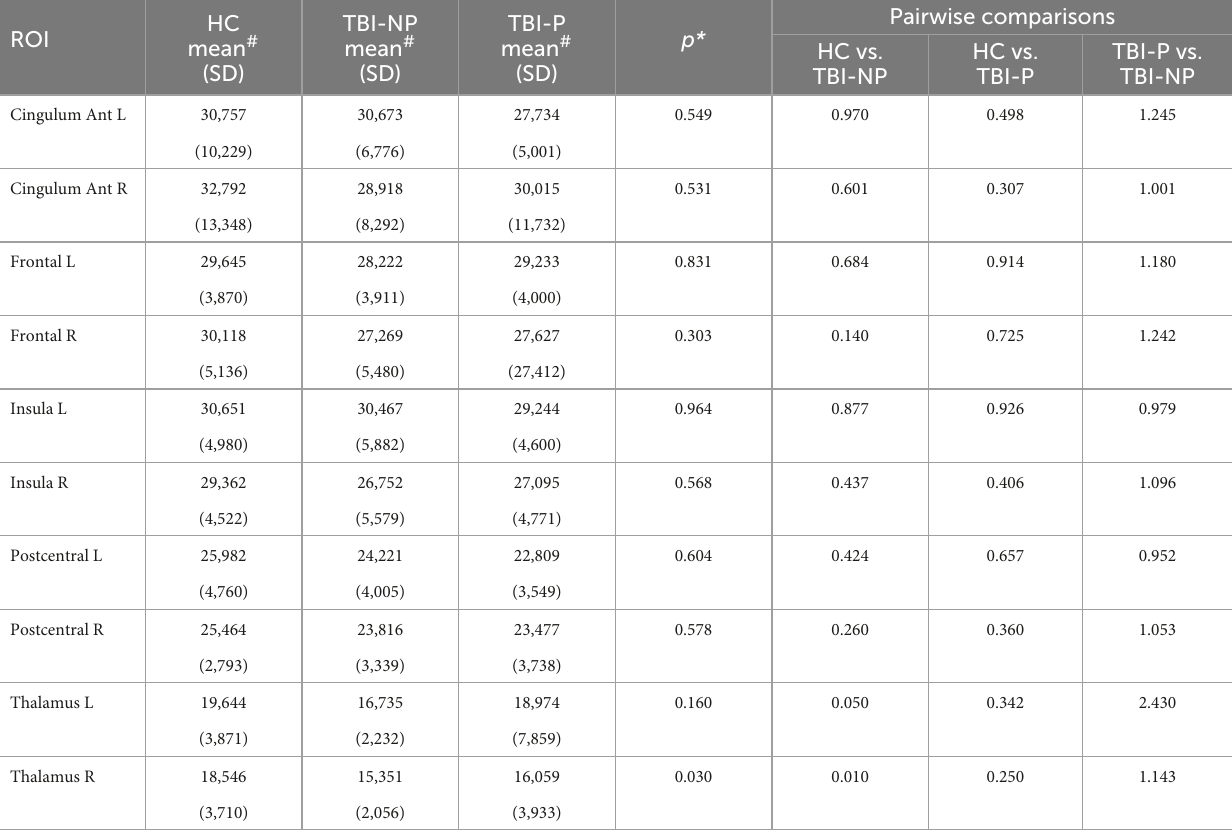
TABLE 6 Results from analysis of covariance (ANCOVA) controlling for age between HC ( N = 31), TBI-NP ( N = 17) and TBI-P ( N = 16) groups for glutamate and glutamine (Glx).